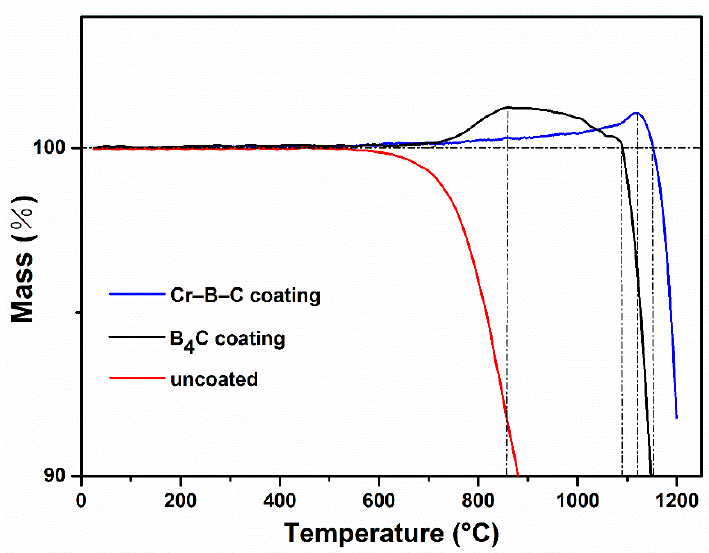
Figure 4. TGA results for the uncoated diamond particles, diamond particles with B 4 C coating, Cr–B–C coating,